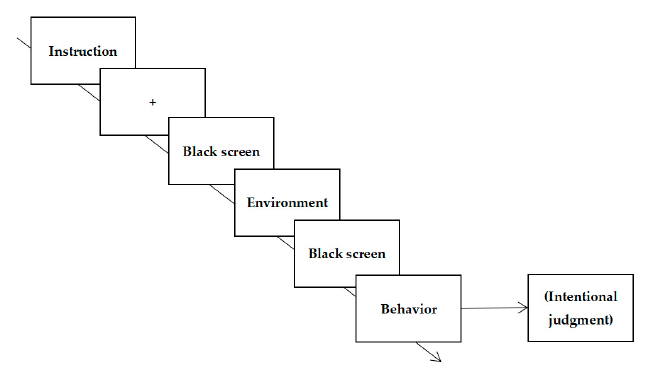
Figure 4. Example of event sequences in Experiment 1.